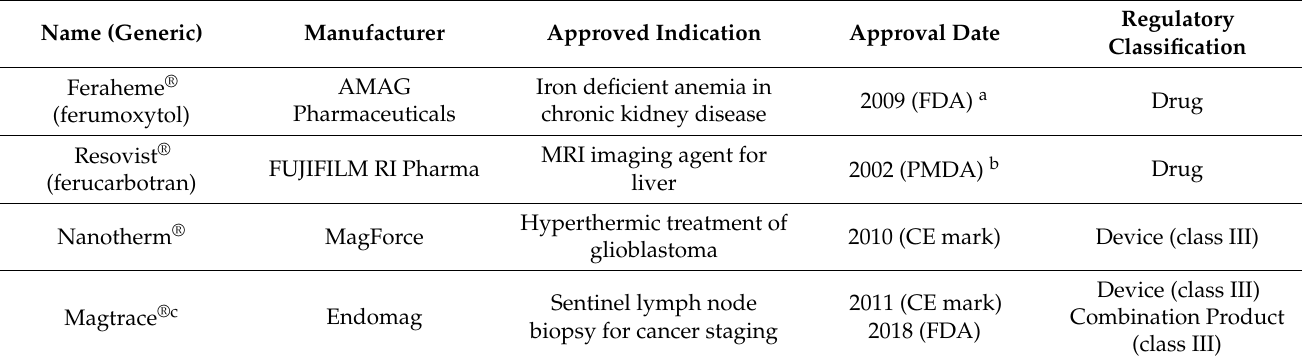
Table 2. Commercially available clinically approved IONPs.